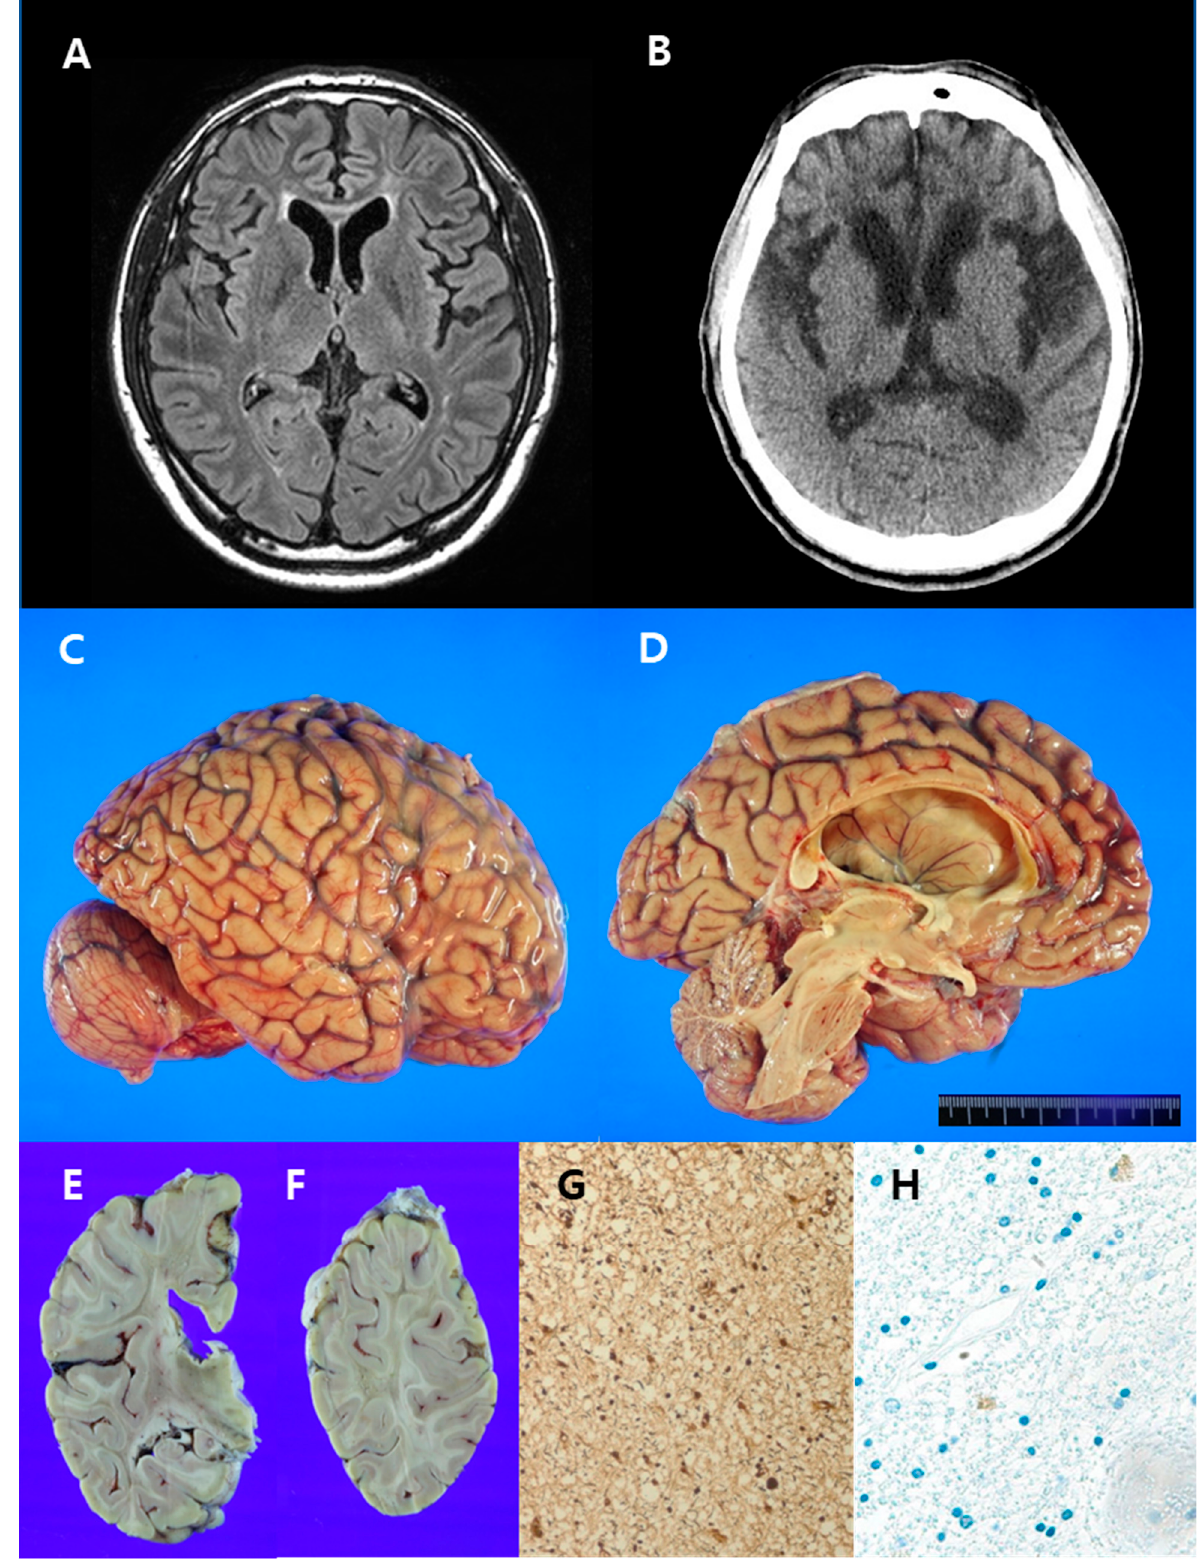
Figure 3. Radiological images, gross and histopathological findings of the brain in case